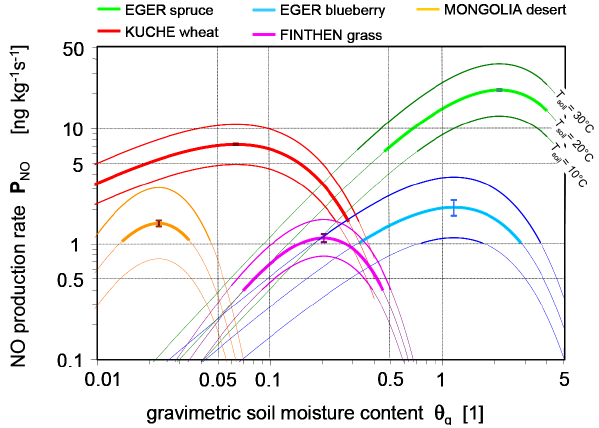
Figure 20. Summary of NO consumption rate coefficient ( k NO ) re- sults of the five soil samples in this study. The curves have been cal- culated using the k NO (θ 0 , T 0 ), θ 0 , θ g,1 , and Q 10_U , NO data listed in Table 2. Thick solid lines represent conditions at T soil = 20 ◦ C, thinner solid lines above and below conditions of T soil = 10 ◦ C and T soil = 30°C, respectively. Solid lines cover the range of those val- ues which have passed corresponding rejection criterion ( = min- imum detectable k NO , see Sect. 5.2). Error bars of k NO (θ 0 , T 0 ) are from Table 2 and indicate respective optimum gravimetric soil moisture contents ( θ 0 ). Note that there is no k NO curve for “MON- GOLIA desert” soil, since the respective Q 10_U , NO value could not be calculated due to non-significant k NO (θ 0 , T 0 ) and k NO (θ 0 , T 1 ) data, see Table